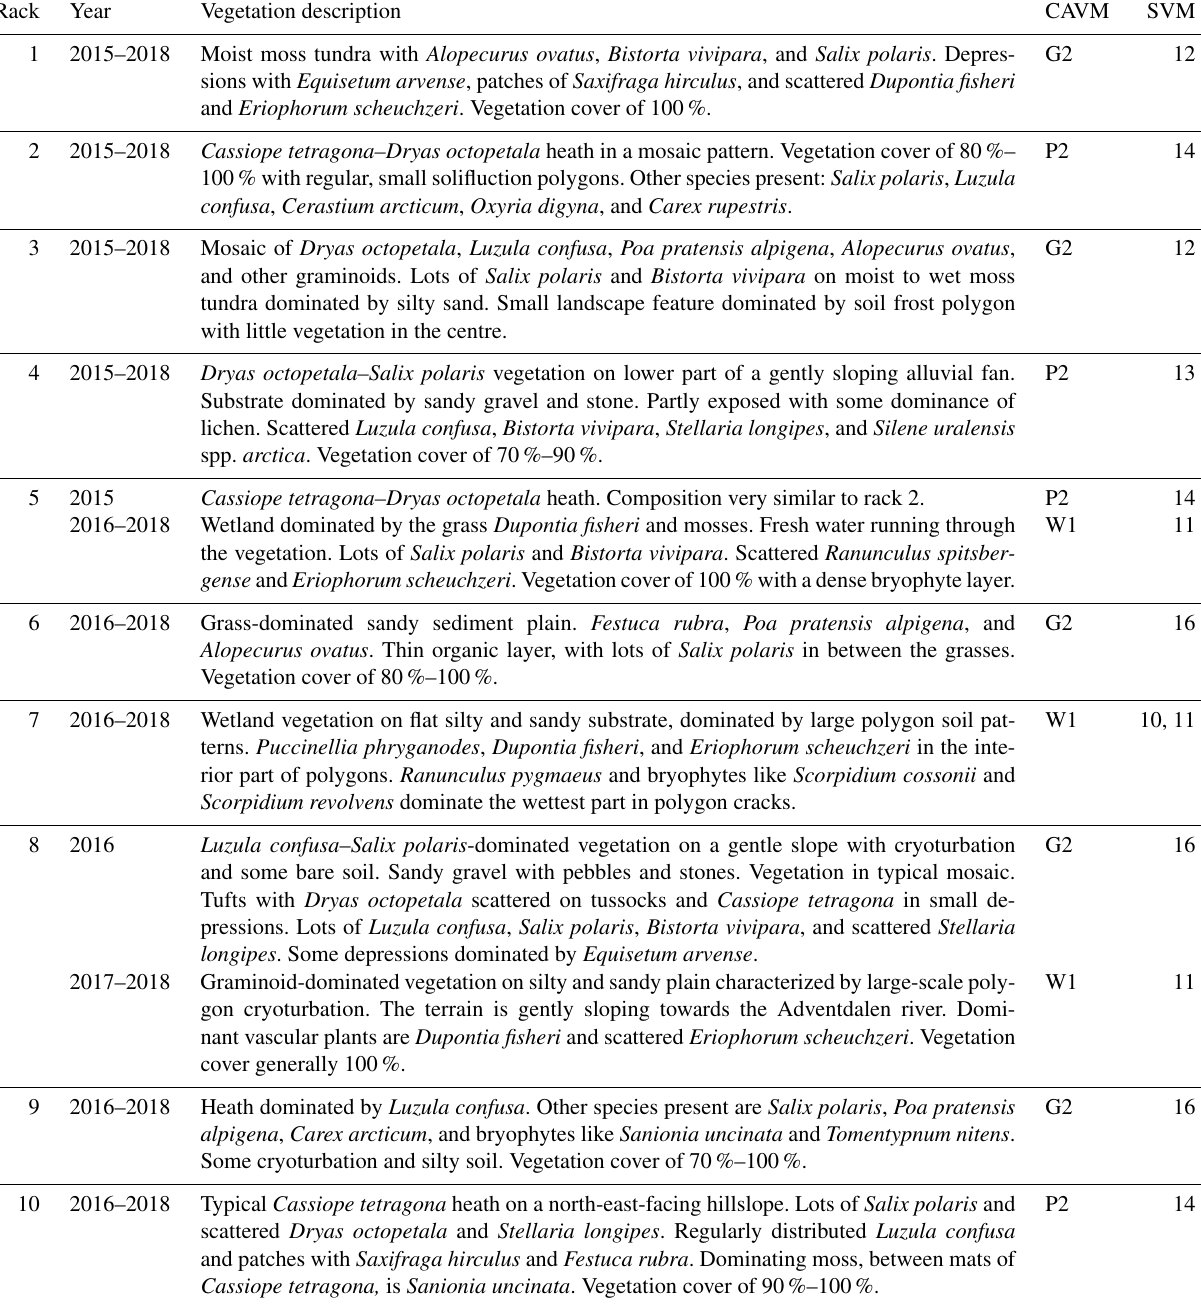
Table 2. Vegetation composition at each rack from 2015 to 2018. Apart from racks 5 and 8, which were moved to different vegetation types, all racks were kept within the same general area with similar vegetation composition. The vegetation classes are according to those defined by the Cirumpolar Arctic Vegetation Map (CAVM; Walker et al., 2005) and the Svalbard Vegetation Map (SVM; Johansen et al.,